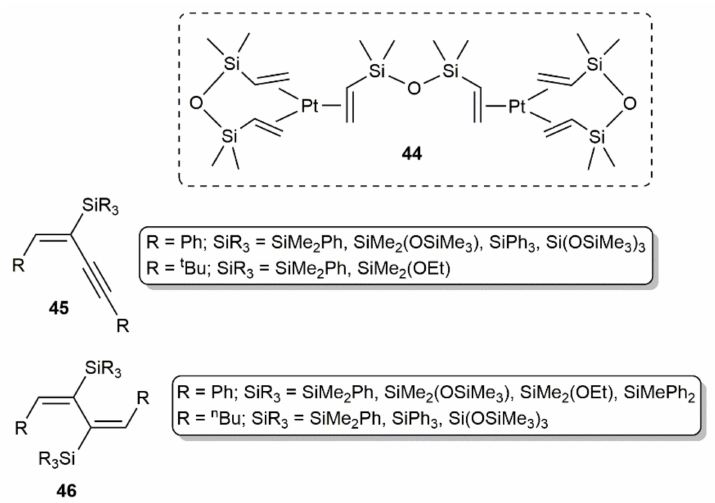
Figure 7. Structure of the Karstedt ´ s catalyst 44 and the silylated compounds 45 and 46 .